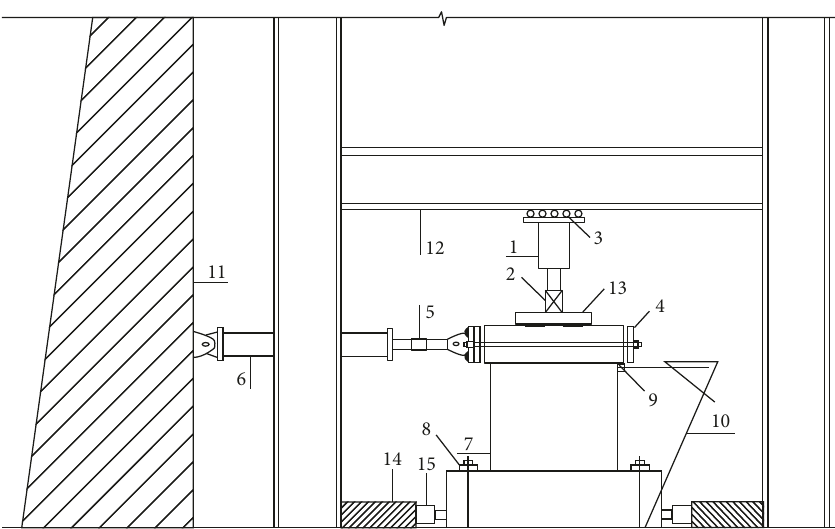
Figure 3: Loading device. (1) 150Tvertical oil Jack; (2) 150Tvertical sensor; (3) sliding support; (4) horizontally connected device; (5) 150T horizontal sensor; (6) 150T horizontal actuator; (7) test piece; (8) anchor bolt; (9) displacement meter; (10) slotted-angle shelving; (11) reaction wall; (12) reaction beam; (13) distribution beam; (14) support; (15) 30T Jack.